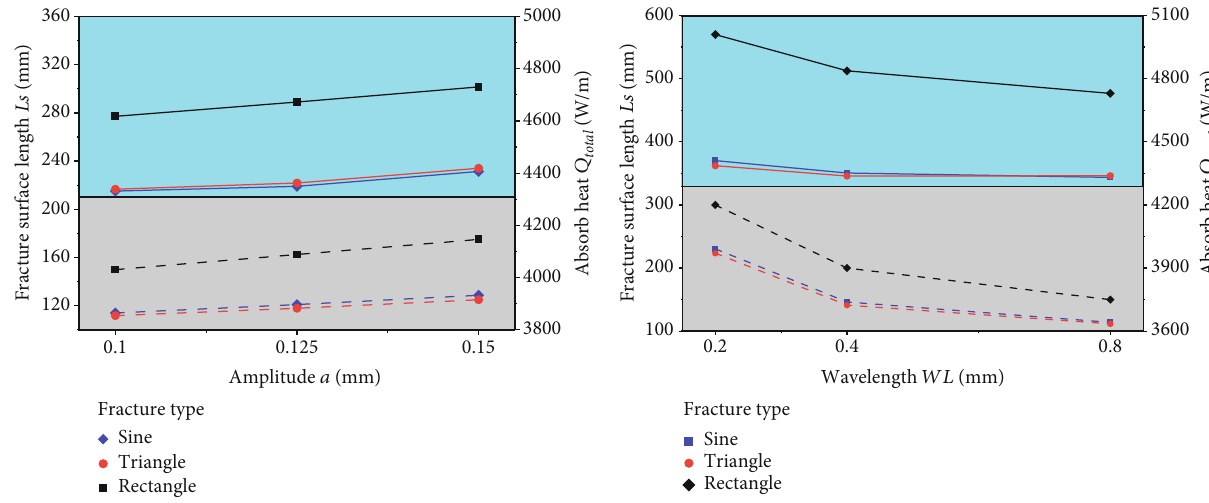
Figure 14: Heat transfer of di ff erent rough fractures with the same fl ow